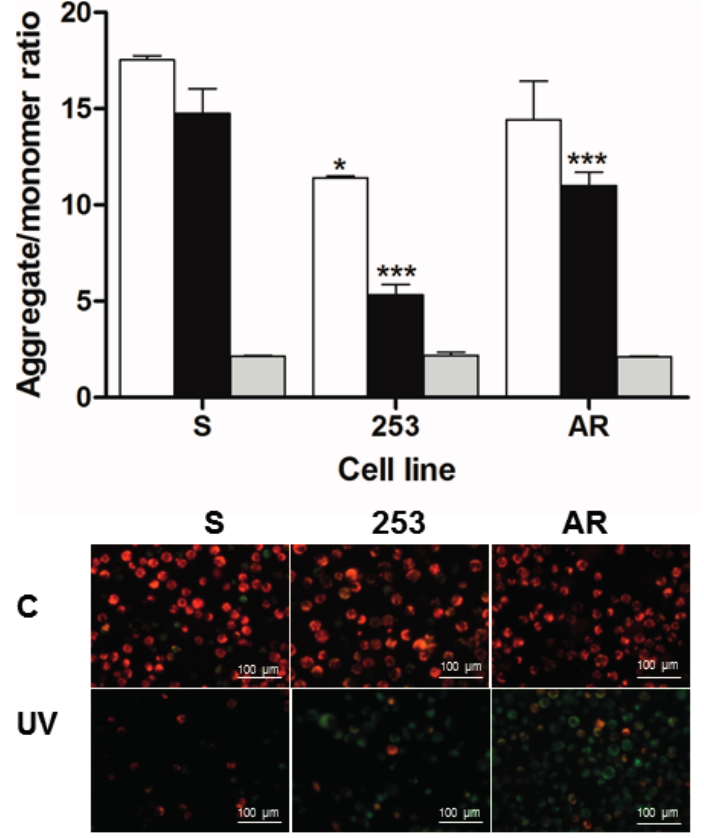
2.5. Imatinib-Resistant Cells Display Lower Mitochondrial Membrane Potential after UV Exposure All BCR-ABL1-transfected cells displayed lower native MMP than their parental, non-transfected counterparts and both imatinib-resistant cell lines had lower native MMP than S cells (Figure 5). UV irradiation lowered MMP in all kinds of cells. The imatinib-resistant 253 and AR cells displayed significantly lower MMP than imatinib-sensitive S cells. These results are in general agreement with those obtained in flow cytometry study, as membrane mitochondrial potential decreases during apoptosis.